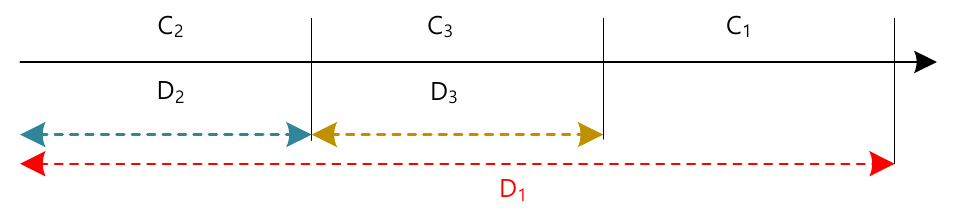
Figure 3. Coverage according to device